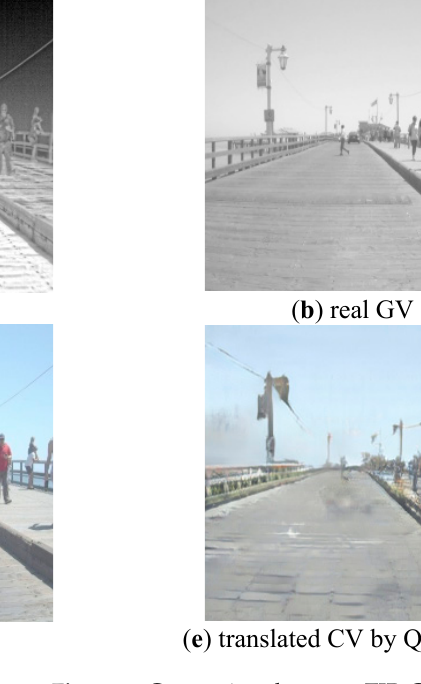
Figure 1. Comparison between TIR-GV-CV and TIR-CV. Although further translation from GV images to CV images is required, there is no blurred edge and color confusion because both effects are translated in the same